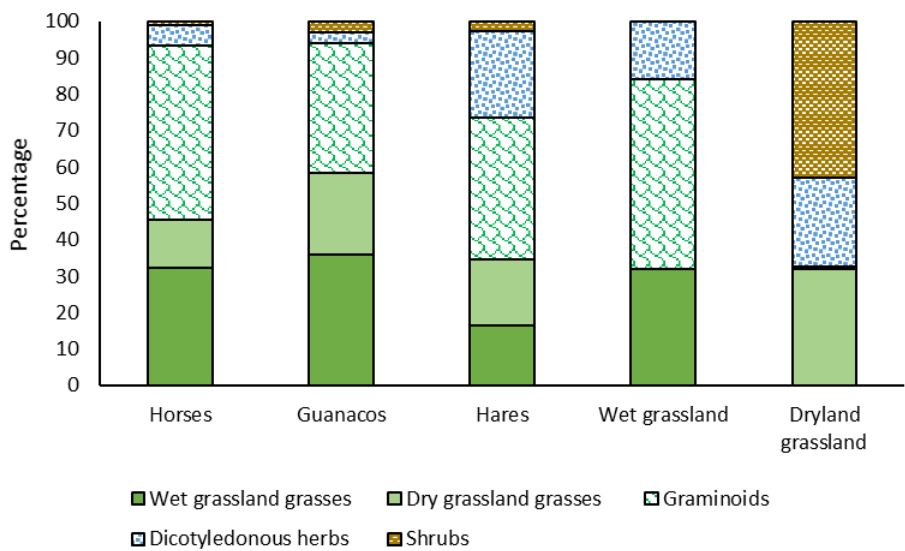
Figure 4. Relative contribution of grasses, graminoids, dicotyledonous herbs, and shrub species, to the diets of horses, guanacos, and European brown hares that graze high mountain ranges of the Coquimbo Region, Chile. The same figure includes the mean contributions of the same functional groups in the botanical composition of the grasslands. Average of two evaluation seasons (2011 and 2012).